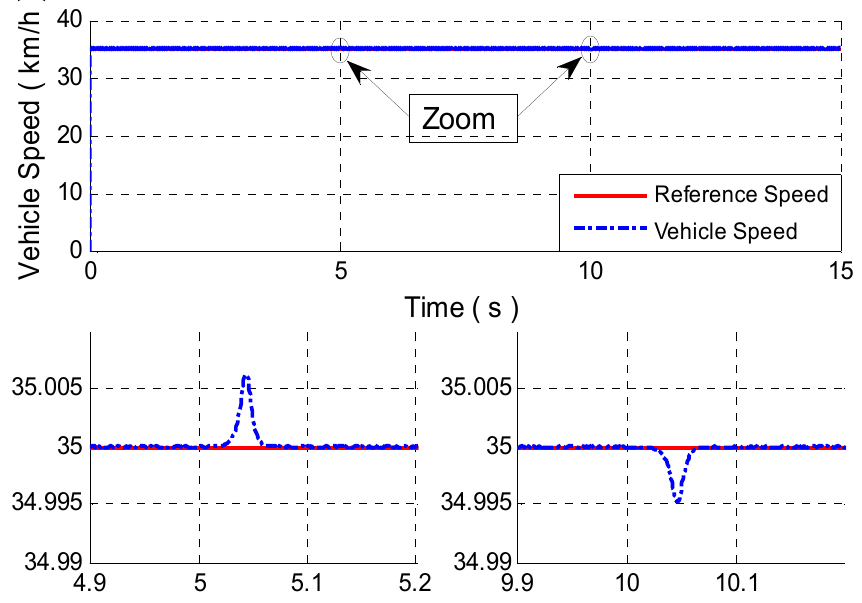
Figure 6. Vehicle speed and its reference with zoom.